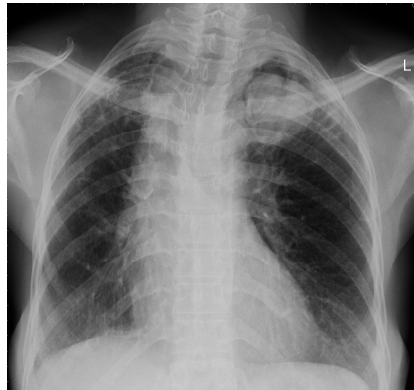
Figure 6. Solitary aspergilloma— Chest X-ray (CXR) demonstrating a left upper lobe aspergilloma in a patient with sarcoidosis.